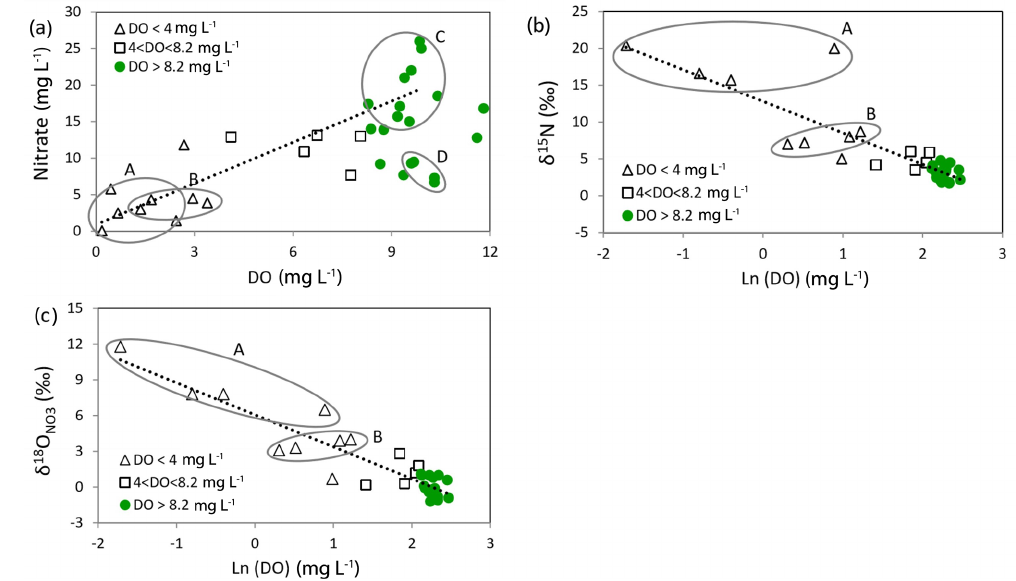
Figure 11. (a) Plot of DO versus nitrate concentration. (b, c) Plots of Ln(DO) versus δ 15 N and δ 18 O NO